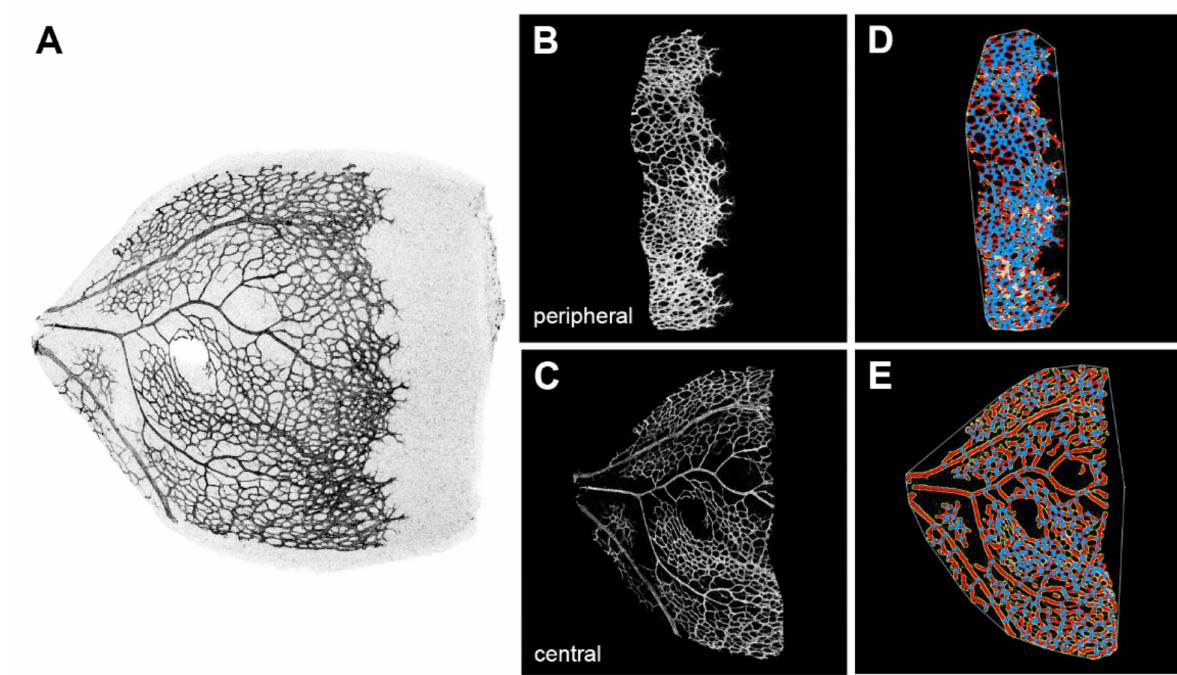
Figure 4. Example for the evaluation of a retinal leaf using the AngioTool software. The retinal leaf ( A ) was divided into a peripheral part ( B ) and a central part ( C ). Vessels (red) and junctions (blue dots) were detected by the software in the digital images ( D , E